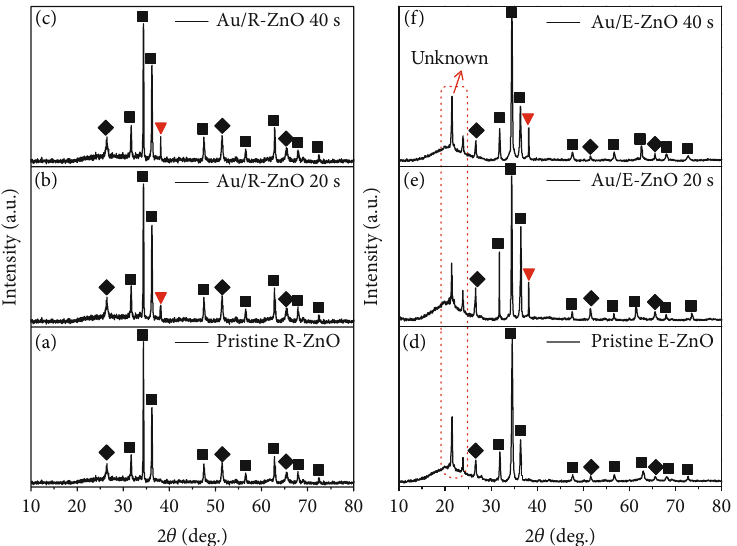
Figure 3: (a – f) X-ray di ff raction (XRD) patterns of pristine R-ZnO, bare E-ZnO, Au/R-ZnO, and Au/E-ZnO heterojunction nanocomposites for di ff erent Au NP deposition times (20 s and 40s), respectively.